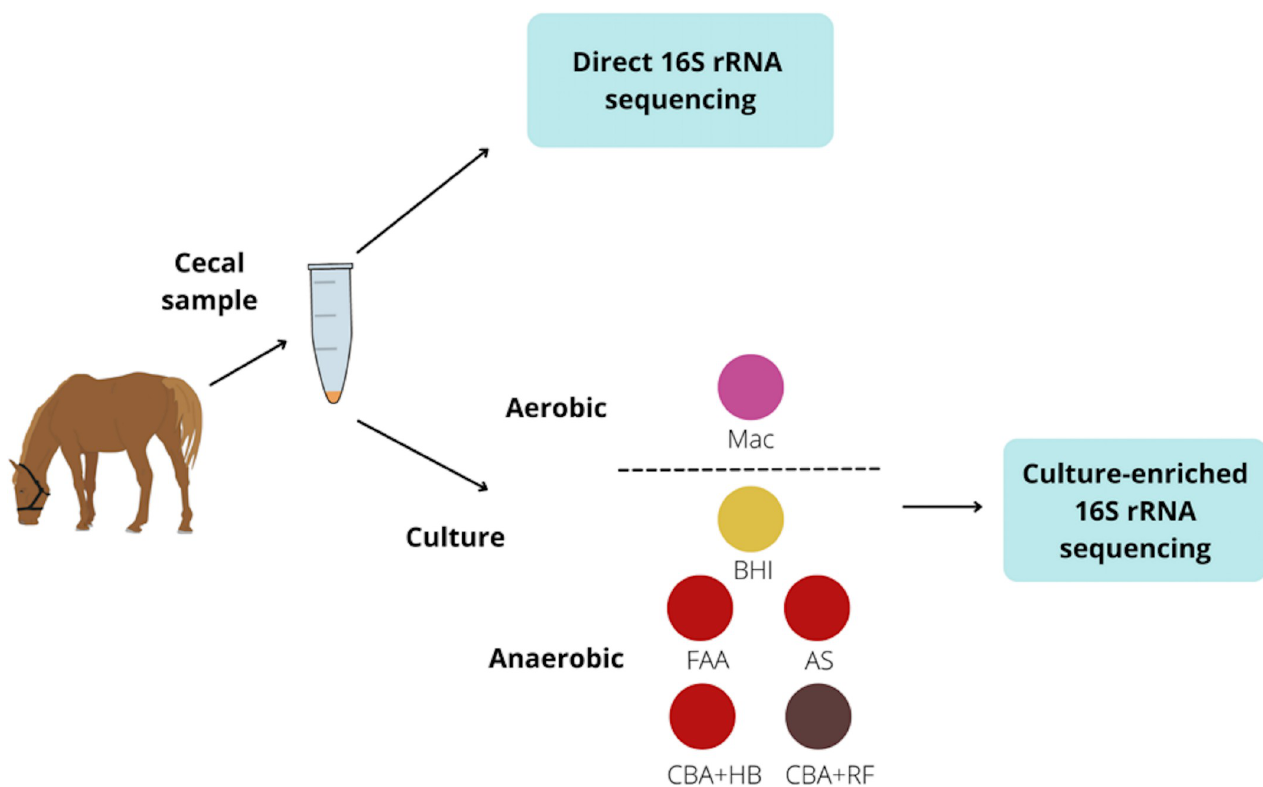
Fig 1. Culture-enriched 16S rRNA gene sequencing workflow. Cecal samples were collected from horses. One aliquot was submitted for direct 16S rRNA sequencing. Other aliquots were plated onto 6 different media types and incubated anaerobically and anaerobically. Colonies were harvested and submitted for culture-enriched 16S rRNA sequencing. Abbreviations: MacConkey agar (Mac), fastidious agar with horse’s blood added (FAA), Columbia agar with horse’s blood added (CBA+HB), Columbia agar with rumen fluid added (CBA+RF), BHI3 with carbohydrate added (BHI), and AS (samples plated on CBA+HB after alcohol